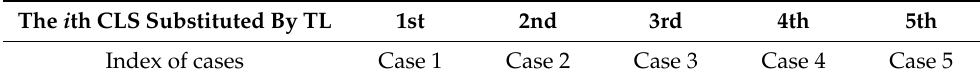
Table 2. The substitutable cases in category